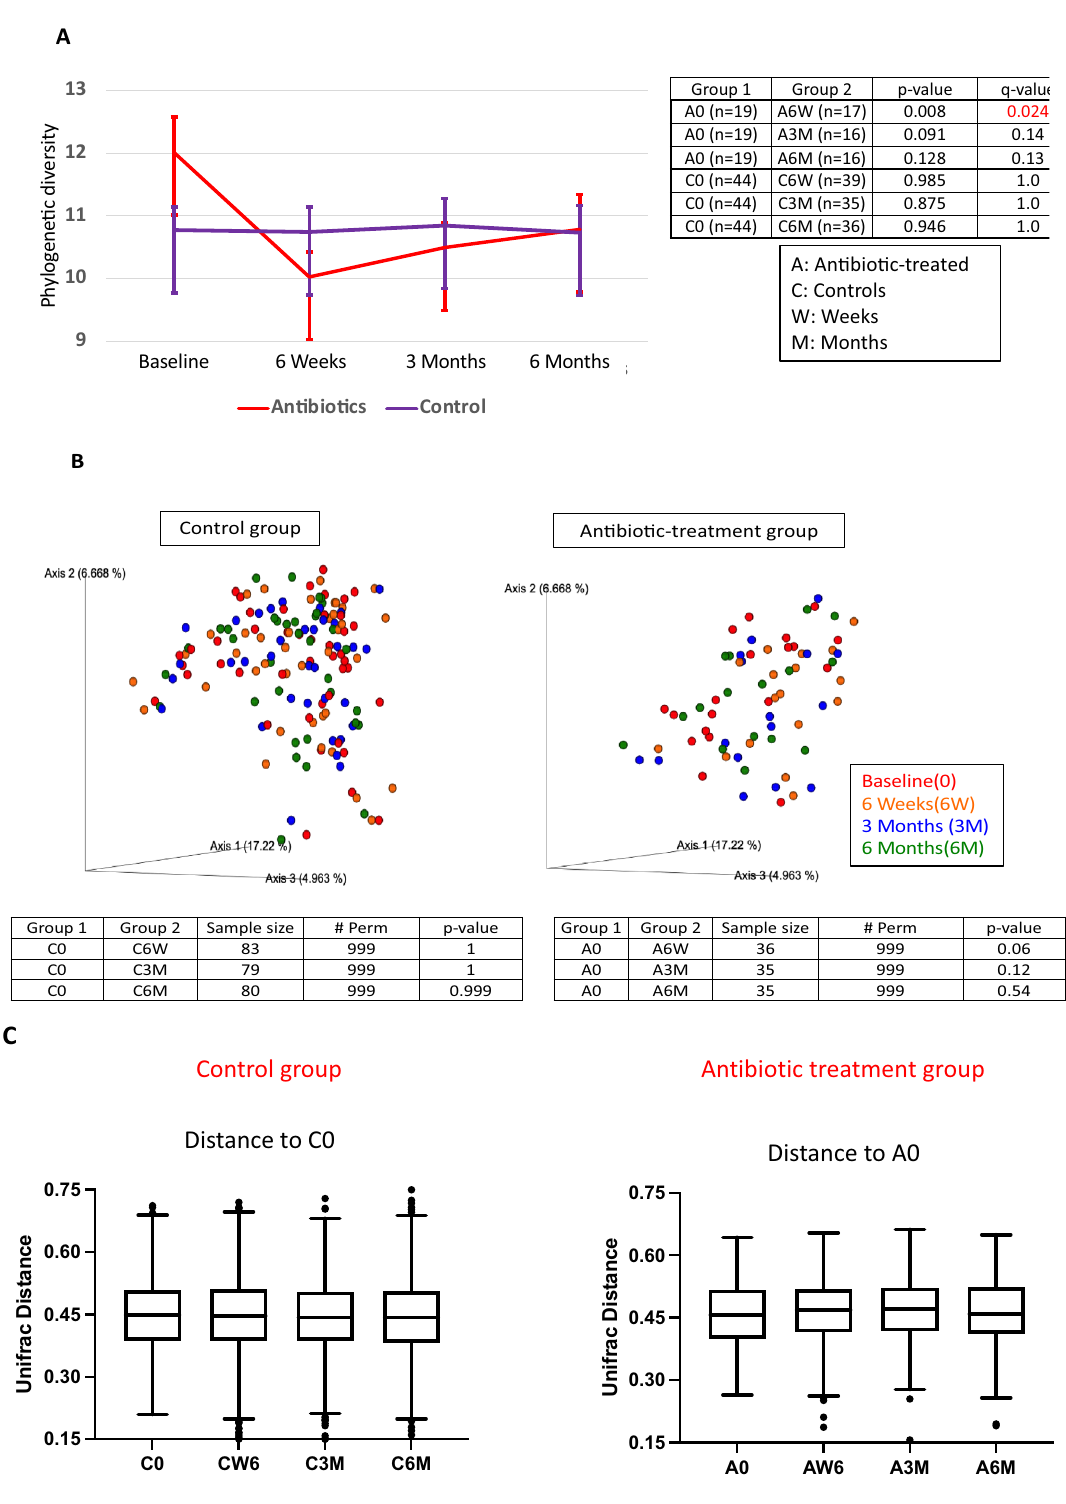
Figure 4. Alpha- and beta-diversity of microbiota in controls and antibiotic-treated subjects over time. Panel ( A ) Phylogenetic diversity over time in the two groups of subjects; Kruskal Wallace analysis. Panel ( B ) Unweighted UniFrac distances over time. Panel ( C ) Comparison of beta diversity between baseline and follow-up specimens in the control and antibiotic treatment groups. Box-and-whisker plots (Tukey) of unweighted UniFrac distance are shown at sequencing depth of 8,000. Comparisons were done between baseline (0) vs. follow up (W6, 3M, 6M), by Pairwise Permanova testing with 999 permutation; no differences were significant at p < 0.05. Panels ( A , B ) are created by QIIME2 software (version 2-2019.1) while Panel ( C ) was created by R software Ggplot2